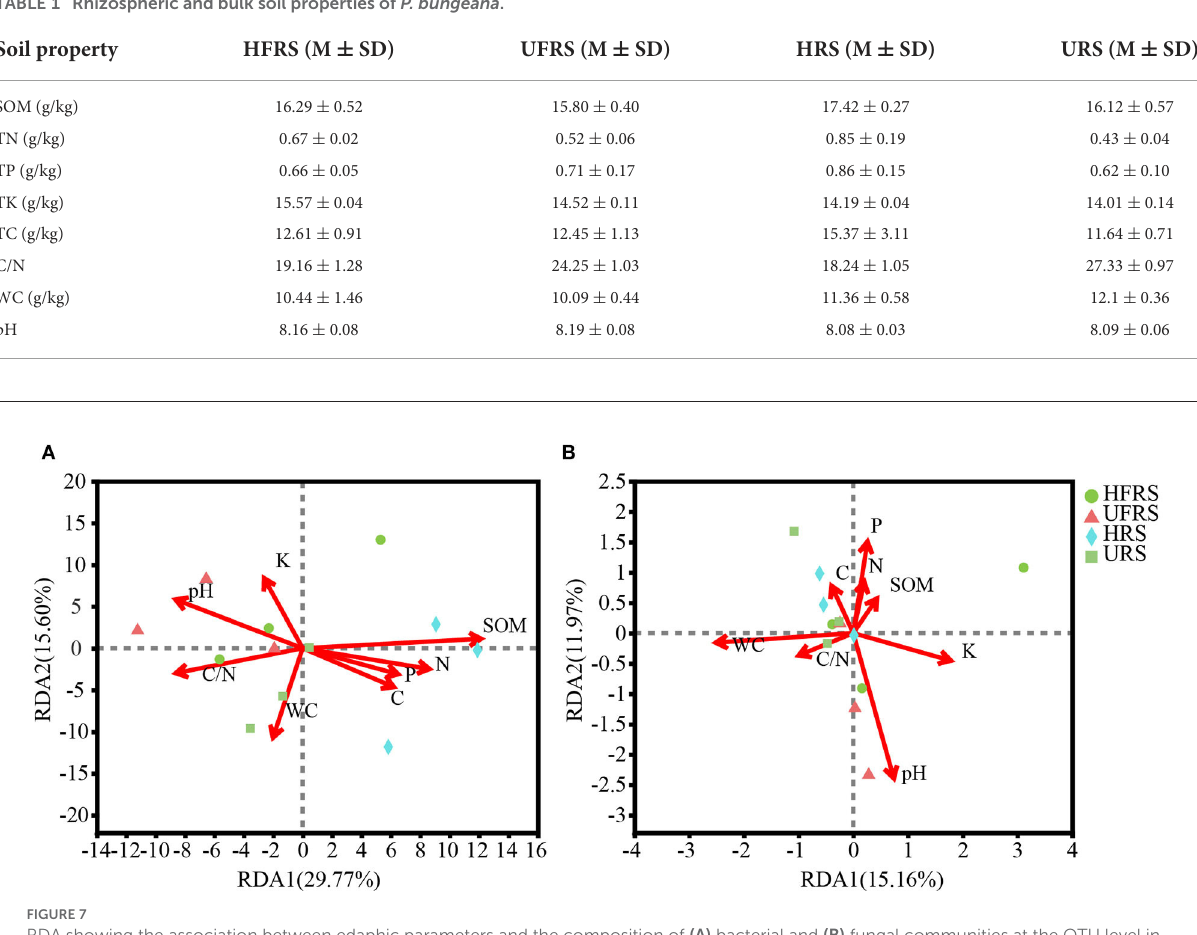
TABLE 1 Rhizospheric and bulk soil properties of P. bungeana .